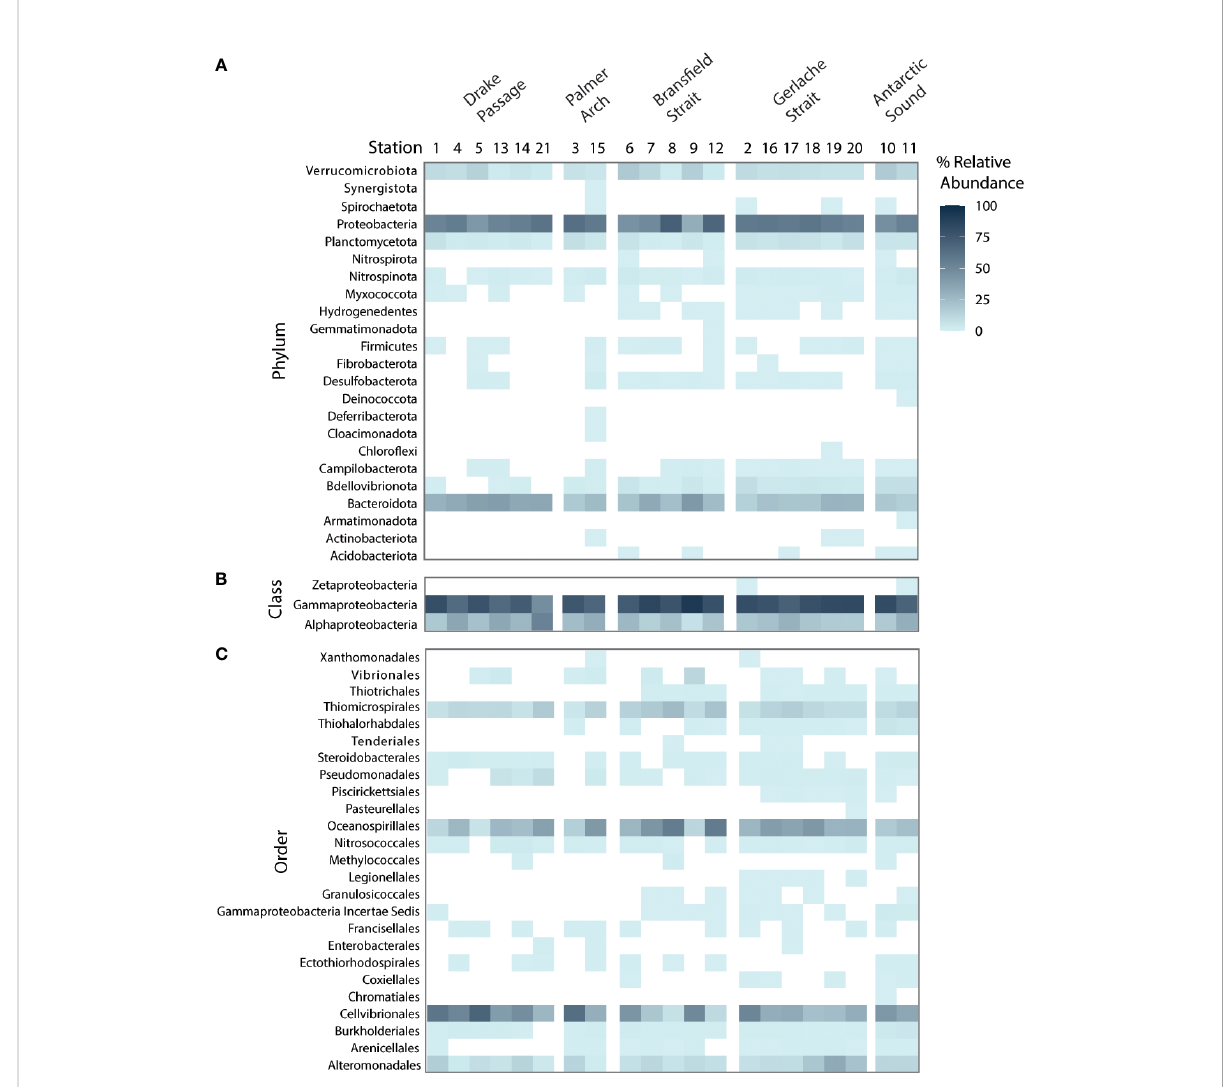
FIGURE 4 Bacterial taxa recovered from high-throughput sequencing of the V4 16S rDNA at the NBP16-08 stations ( n = 21) grouped by sampling location by the % relative abundance of the 16S rDNA gene. A white box denotes absence in a sample. (A) The phyla of all bacterial amplicon sequence variants (ASVs) identi fi ed. (B) The classes of Proteobacteria identi fi ed. (C) The orders within Gammaproteobacteria identi fi